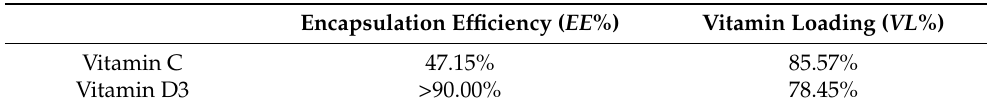
Table 1. Encapsulation Efficiency (EE%) and Vitamin Loading (VL%) of lipid-based vitamin C and lipid-based vitamin D3.